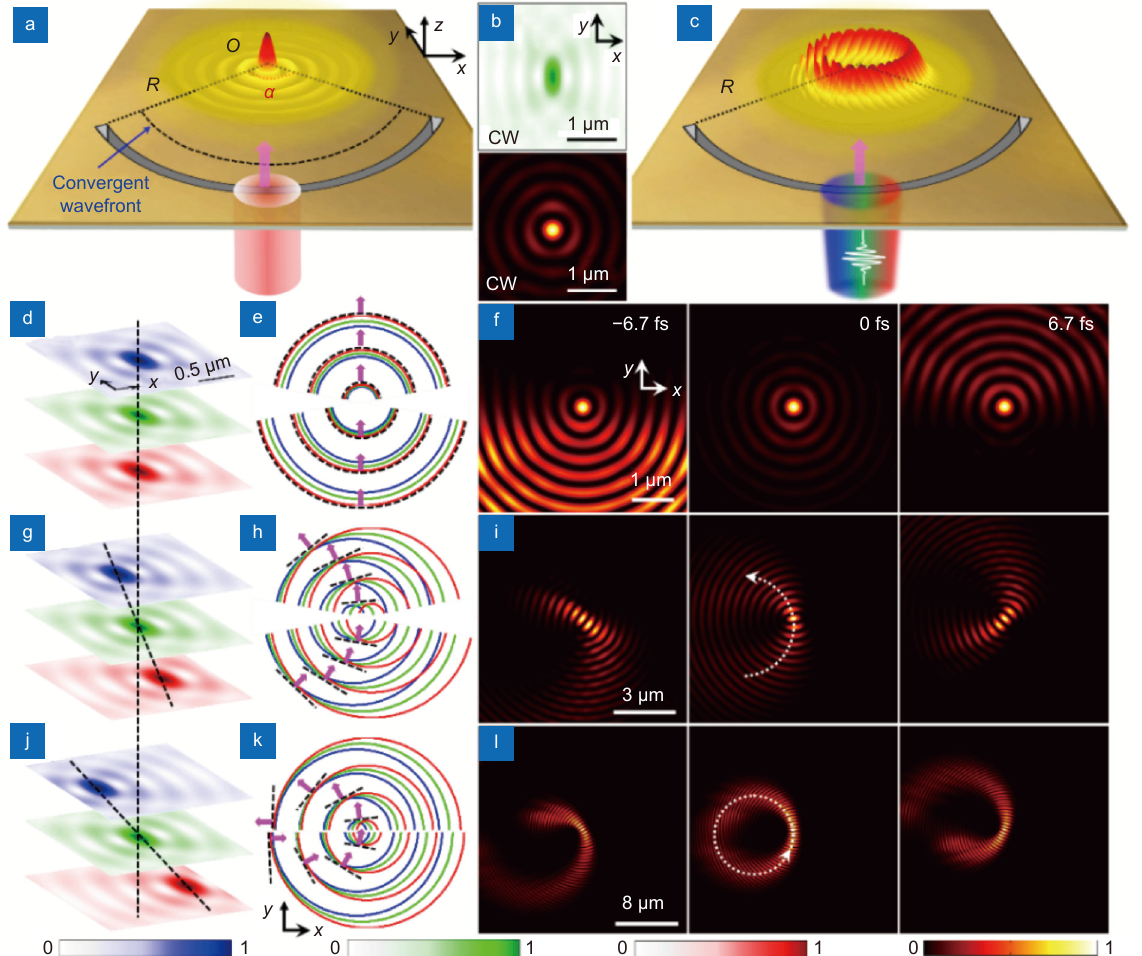
Fig. 2 | ( a ) Schematic of the spatial FT for a SPP with continuous-wave (CW) incident light. ( b ) Spatial distribution of the time-averaged field | E z | 2 excited by an 800 nm-wavelength CW source (top) and corresponding temporal wavefront in the SPP focal region (bottom). ( c ) Schematic of spatiotemporal FT for a SPP pulse and the angularly dispersed femtosecond laser beam, showing the instantaneous ring-shape formed by the SPP pulses in the focal region. ( d ) Spatial distributions of the time-averaged field | E z | 2 excited by the 756(blue)/800(green)/850(red)-nm wavelength component of the angularly dispersed femtosecond light with θ =0° in the focal region. ( e ) Spatiotemporal evolution of the wavefront of the SPP pulses in the focal region corresponding to (d). The blue/green/red curves mark the equiphase surfaces of the SPP pulses excited by the 756/800/850-nm wavelength components in the focal region, respectively; the black dashed curves marks wavefront of the pulse with its dir- ection of propagation indicated by purple arrows. ( f ) The timing diagram for the evolution of the SPP pulse in the focal region corresponding to (e), the time instants being –6.7 fs (before focus), 0 fs (at focus), and 6.7 fs (after focus). ( g – i ) and ( j – l ) are similar in (d–f) except with θ = 5° and θ = 10°, respectively. All time-averaged fields and timing diagrams are normalized by their respective maximum values. Other settings are R =40 μm, α =180°, τ =10